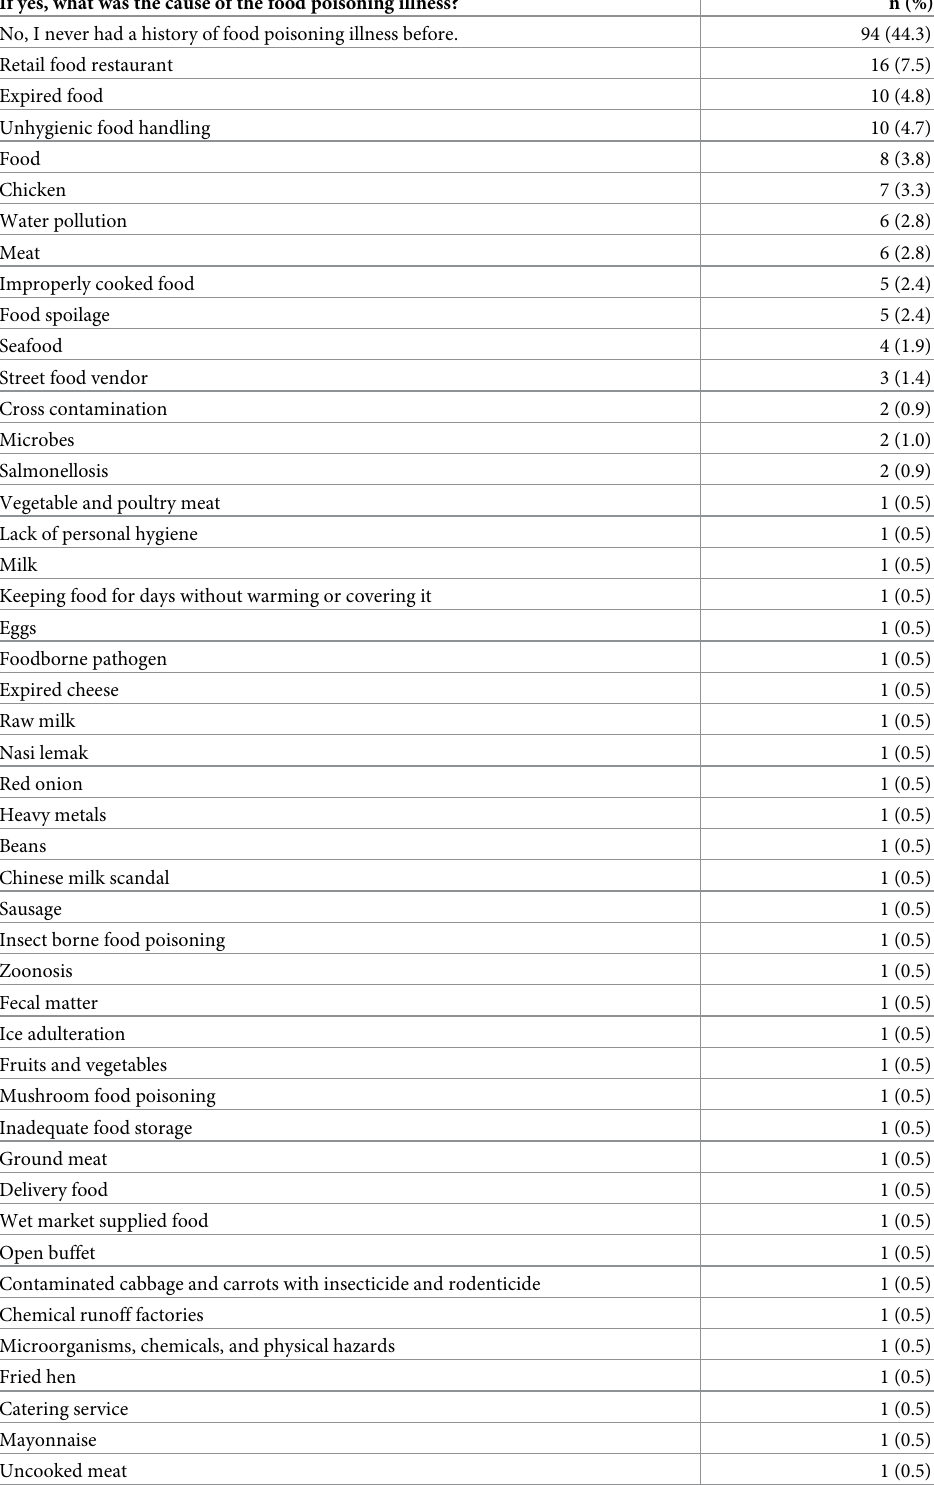
Table 5. Distribution of the respondents according to what was the cause of their food poisoning illnesses (N = 212). If yes, what was the cause of the food poisoning illness? n (%) No, I never had a history of food poisoning illness